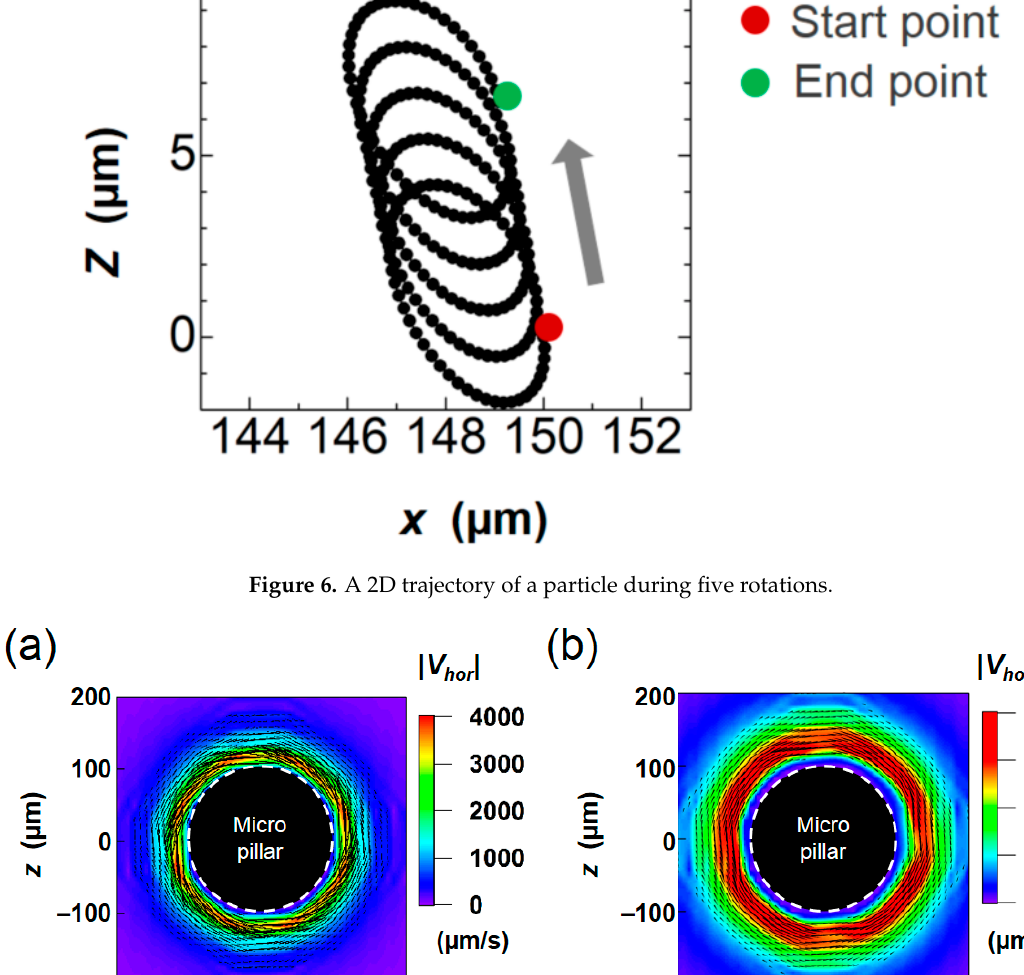
Figure 6. A 2D trajectory of a particle during five rotations.